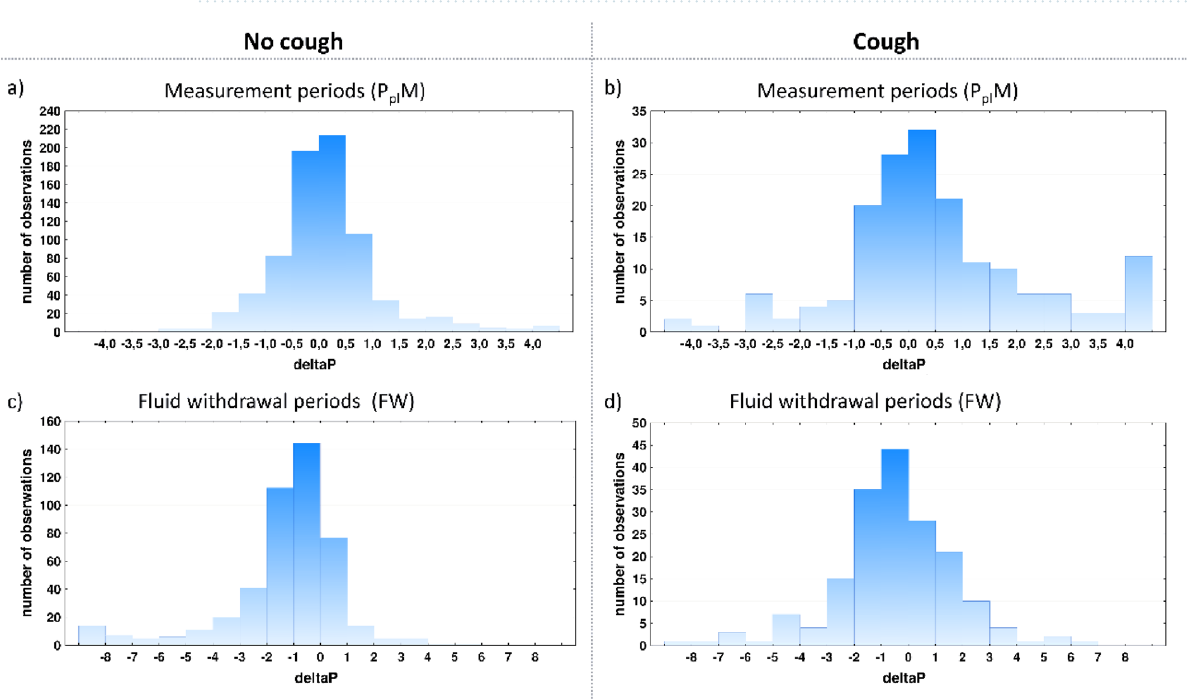
Figure 1. Influence of cough on the ∆P distribution during P pl measurement periods (P pl M) ( a and b ) and during fluid withdrawal periods (FW) ( c and d ). ( a ) the distribution for P pl M without cough, ( b ) the distribution for P pl M with cough episodes, ( c ) the distribution for FW with no cough, ( d ) the distribution for FW with cough episodes. The figure was created using graph tool included in Statistica 13.1 software package (StatSoft Inc., Tulsa, USA) for which the required license has been purchased by the authors’